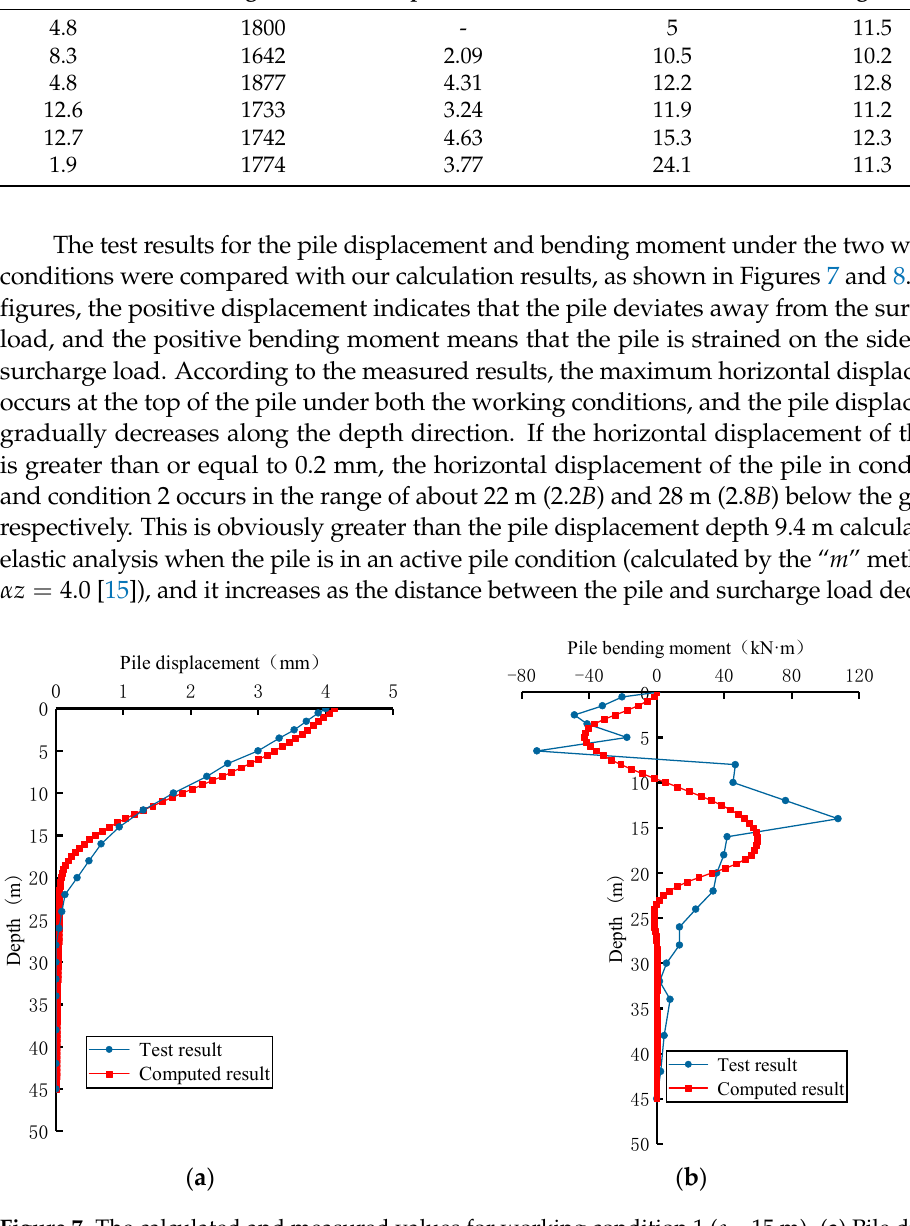
Figure 7. The calculated and measured values for working condition 1 ( e = 15 m). ( a ) Pile displace- ment; ( b ) pile-bending moment.